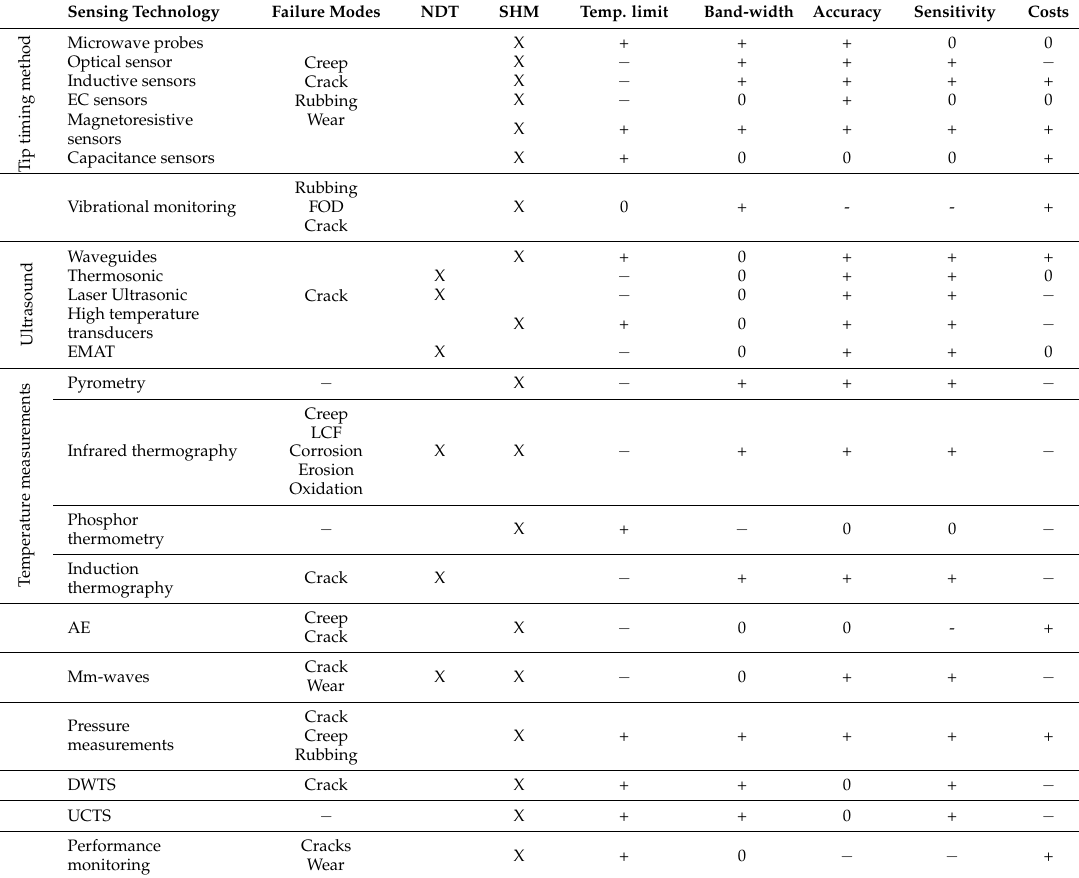
Table 2. Summary–Properties of sensor